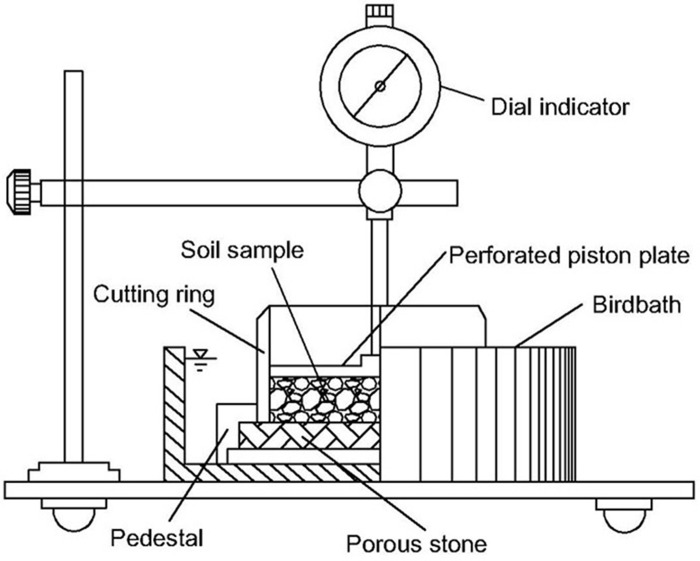
Experimental process profile.